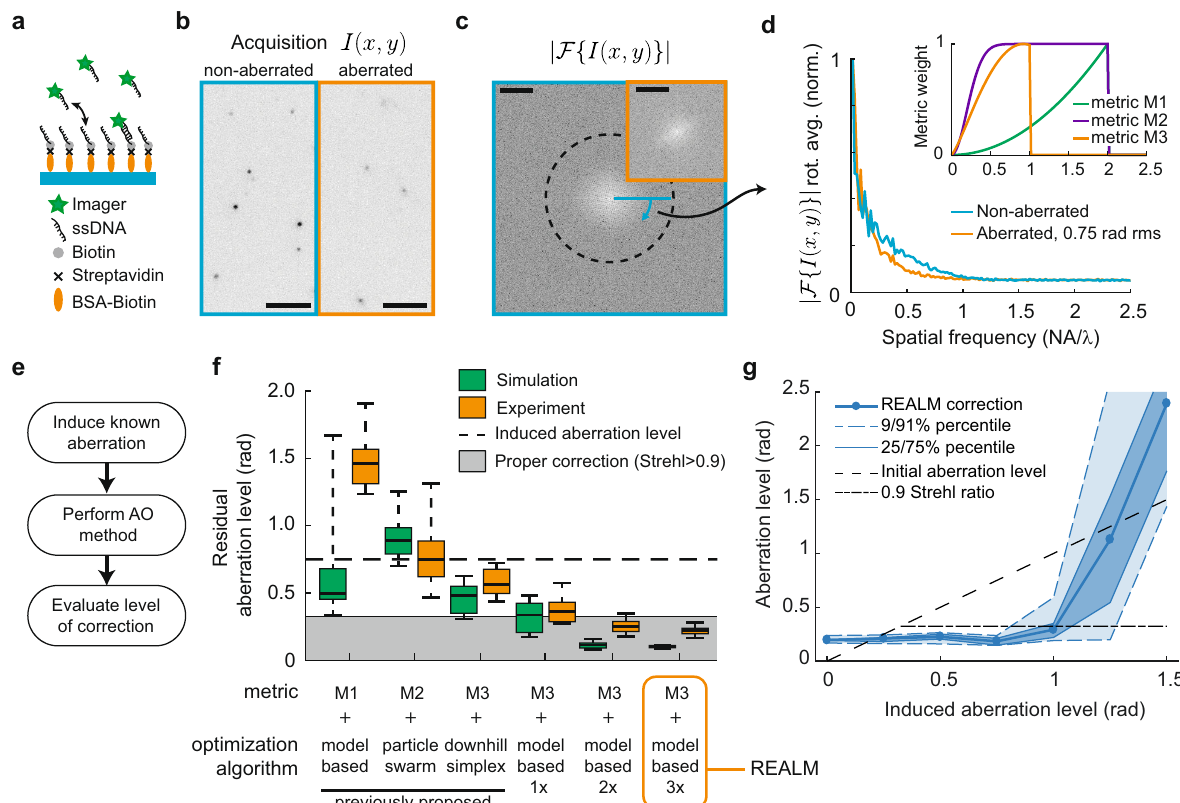
Fig. 1 Systematic comparison between different AO methods reveals that only REALM achieves robust correction. a DNA-PAINT test sample: imager strands bind transiently to the coverslip, mimicking single-molecule blinking with consistent signal levels for many hours. b Representative acquisition of a non- and 0.75-rad RMS aberrated acquisition ( I(x,y) ) corresponding to f ( n = 625). Scale bar indicates 5 μ m. c Absolute value of the 2D Fourier transform of a non-aberrated acquisition and aberrated acquisition of b (orange insert, center crop) ( |F{I(x,y)}| ). Dashed line indicates 2NA/ λ . Scale bars indicate NA/ λ . d The rotational average of c shows that noise dominates spatial frequencies above 1 NA/ λ . The major decrease in the MTF due to aberrations occurs between 0.25 and 1 NA/ λ . Insert shows the spatial frequency weights of the different proposed metrics. e Strategy for comparing AO methods by inducing known aberrations in a well-corrected system. f Performance of different AO metrics and optimization algorithms. Metric 3 in combination with model-based optimization leads to robust correction in three correction rounds (297 acquisitions), and we termed this approach REALM. Boxplot indicates 9/91-percentile, 25/75-percentile, and median for 25 random aberration con fi gurations of 0.75 rad rms wave-front error consisting of random combinations of Zernike modes up to the fourth radial order (excluding piston, tip, tilt, and defocus). Each frame (400 × 400 pixels, 26 × 26 μ m) contains on average 13 emitters, emitting 2500 photons with a background of 20 photons per pixel. See Supplementary Fig. 1 for more details. g Performance of REALM as function of induced aberration level (10 random aberration con fi gurations). Each frame (400 × 400 pixels, 26 × 26 μ m) contains on